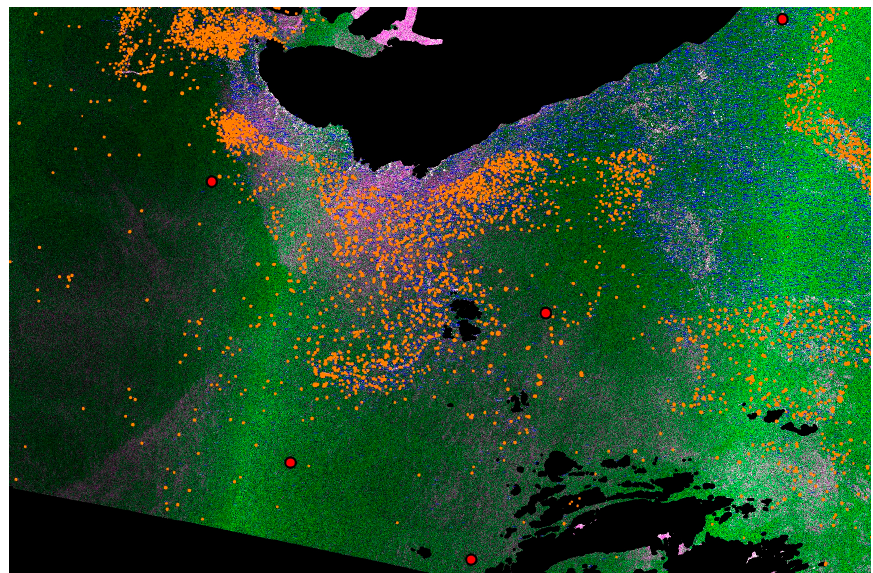
Figure 5. April 18, 2020, Disko Bay Sentinel-1 RGB composite cropped with a coastline and overlaid on a Sentinel-2 image mosaic.